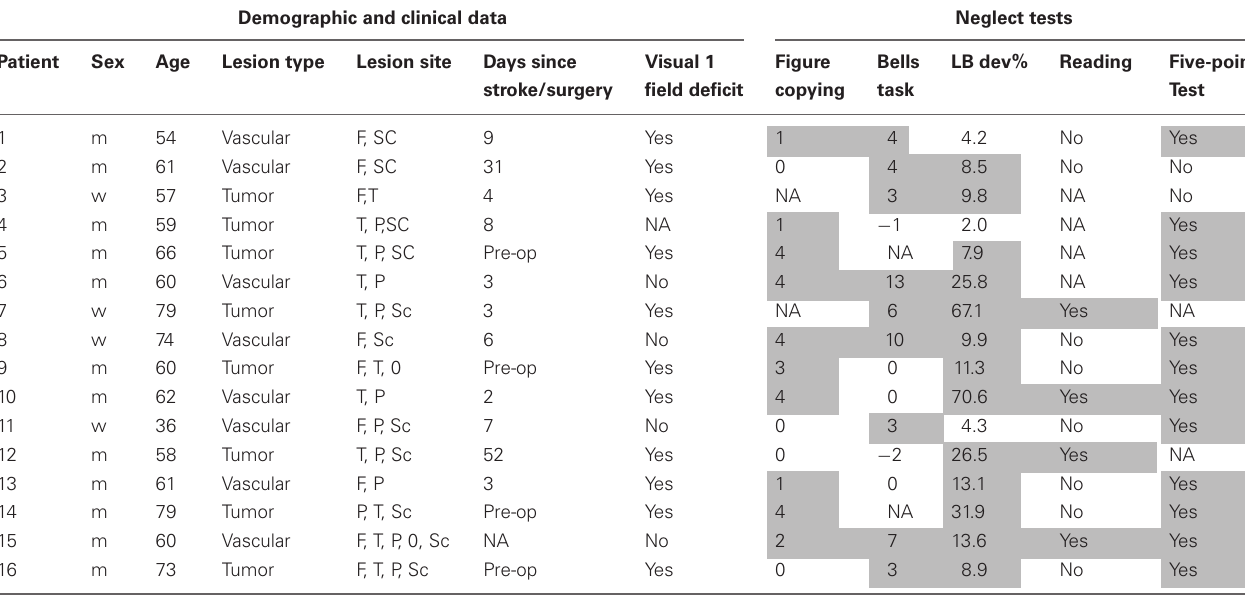
Table 1 | Demographic, clinical, and neuropsychological details of neglect patients with right brain damage. Demographic and clinical